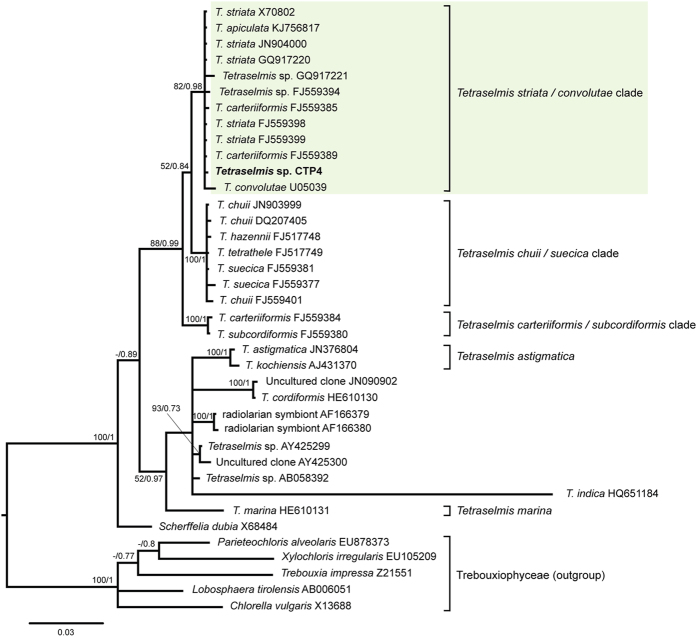
Bayesian inference tree of species of the Chlorodendrophyceae class inferred using 18S rDNA sequences.Maximum-likelihood bootstrap values (>50) and Bayesian inference posterior probabilities (>0.70) are indicated at the branches, respectively. The CTP4 strain, isolated in this study, clustered with the striata/convolutae clade of the Tetraselmis genus.